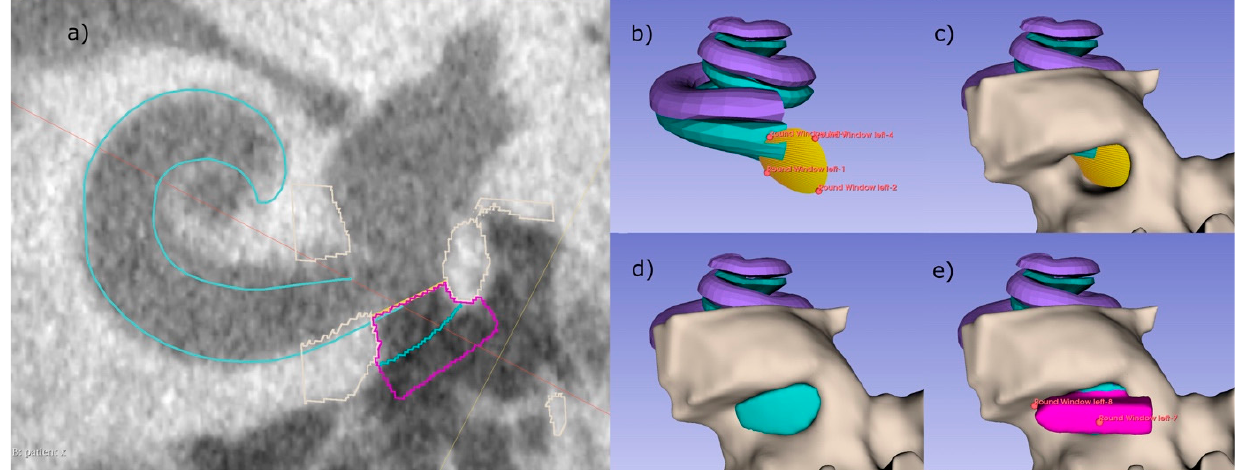
Figure 3. RNI creation using the developed semi ‐ automated software as 3D Slicer™ plugin. ( a ) A CBCT slice of the basal turn of the scala tympani (cyan) with the implant including handle (pink) sitting inside the RWN. ( b – e ) 3D visualization of the individual steps, that are also visible as outlines in ( a ). ( b ) Four control points are placed, defining the RWM (yellow) and limiting the backside of the implant body. ( c ) The bone (light gray) surrounding of the RWN is segmented by thresholding, allowing the RWN to be filled (cyan, d ). In a last step, a handle is added to the implant (pink), helping to define the orientation of the implant.